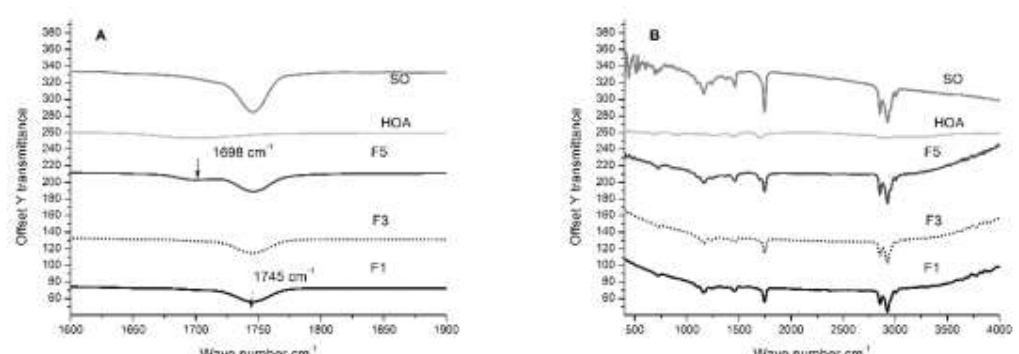
Figure 4. FTIR spectra as the A shows the carbonyl group region, where B displays the whole spectrum.